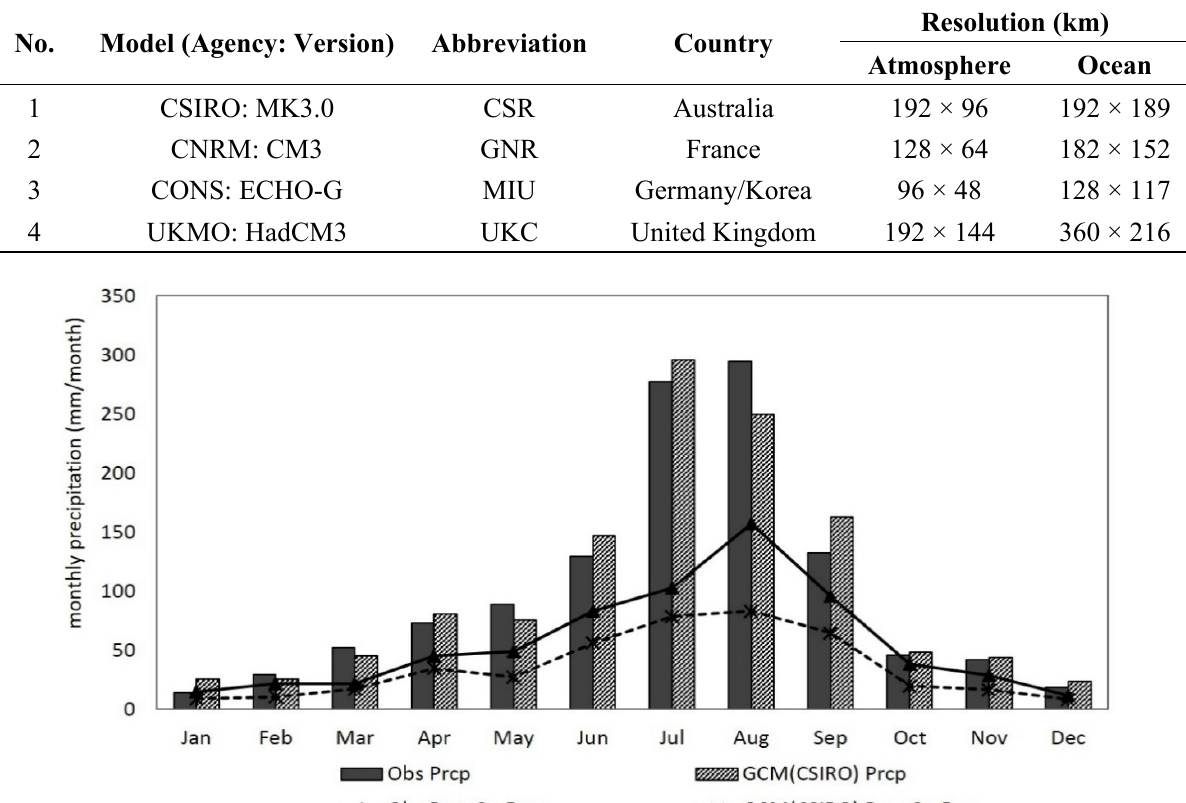
Table 2. GCMs used in this study.